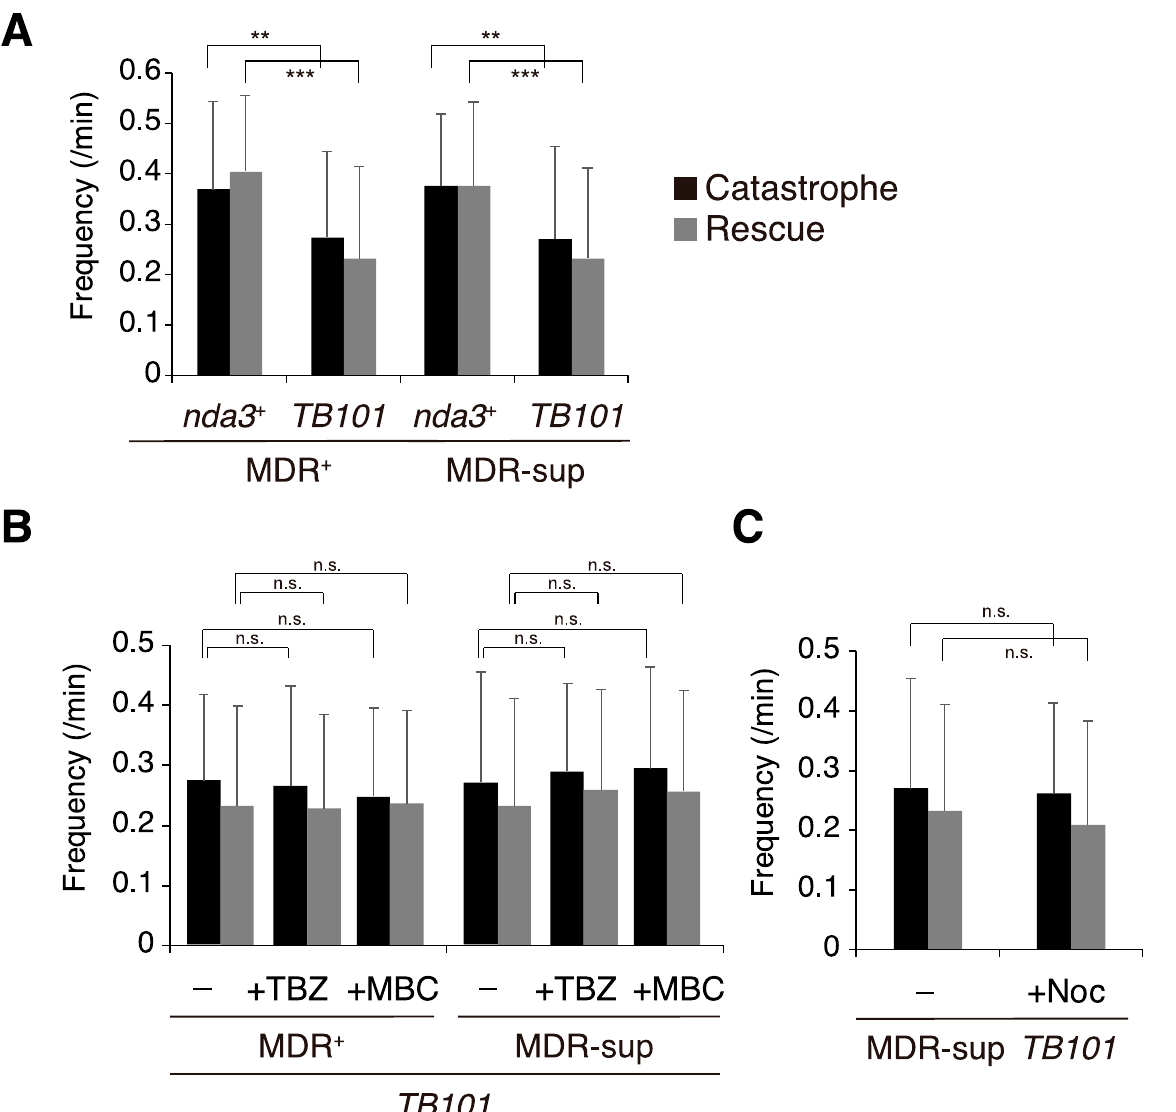
Figure 5. Microtubules in nda3-TB101 cells are less dynamic than those in WT cells. ( A ) Frequencies of catastrophe and rescue in cytoplasmic microtubules were monitored in the absence of drugs using WT ( nda3 + ) and nda3-TB101 strains expressing GFP-Atb2 in the MDR + (left) and MDR-sup (right) backgrounds. In both backgrounds, microtubules in nda3- TB101 cells reduced frequencies of both catastrophe and rescue. MDR + nda3 + , n = 56 bundles; MDR + nda3-TB101 , n = 56; MDR-sup nda3 + , n = 54; MDR-sup nda3-TB101, n = 53. Left, ** p = 0.0022 < 0.01; *** p = 9.4 × 10 − 8 < 0.001 (Student’s t -test). Right, ** p = 0.0027 < 0.01; *** p = 8.5 × 10 − 5 < 0.001 (Student’s t -test). ( B ) Frequencies of microtubule catastrophe and rescue in the nda3-TB101 mutant in the presence of TBZ (50 µ g/mL), MBC (50 µ g/mL), or DMSO (for control, –) were monitored as in A. Left (MDR + ), +DMSO, 56 bundles; +TBZ, n = 54; +MBC, n = 55. Right (MDR-sup), +DMSO, n = 53 bundles; +TBZ, n = 54; +MBC, n = 52. Not significant, n.s. (Student’s t -test). ( C ) Frequencies of microtubule catastrophe and rescue were monitored in the presence of nocodazole (15 µ M) or DMSO (for control, –). +DMSO, n = 51 bundles; +Noc, n = 53. Note that samples for control (–, MDR-sup TB101 ) are shared in experiments for B and C.